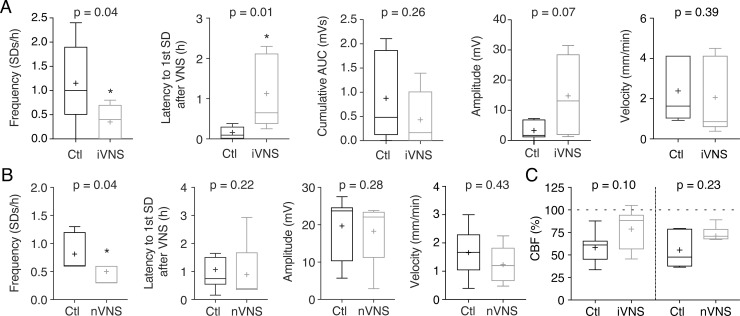
nVNS and iVNS reduce SD frequency during focal ischemia.(A) iVNS, administered 30 min after MCAO for 60 min, strongly reduced SD frequency and increased the latency to the first SD after iVNS initiation, whereas the cumulative area under the curve (AUC) as well as amplitude and SD velocity remained unchanged (n = 8 rats undergoing iVNS vs. n = 8 rats undergoing a sham VNS procedure; Mann-Whitney test for all comparisons). (B) nVNS, administered 30 and 47 min after MCAO for 2 min each, reduced SD frequency after VNS initiation as well. The latency to the first SD, SD amplitude, and velocity remained unchanged (n = 8 rats undergoing nVNS vs. n = 8 rats undergoing a sham VNS procedure; Mann-Whitney test for all comparisons). (C) Relative changes in cerebral blood flow (CBF) in peri-infarct cortex, measured using laser speckle contrast imaging, showed no significant effects of either iVNS or nVNS (n = 8 rats in each group; Mann-Whitney test for both comparisons).